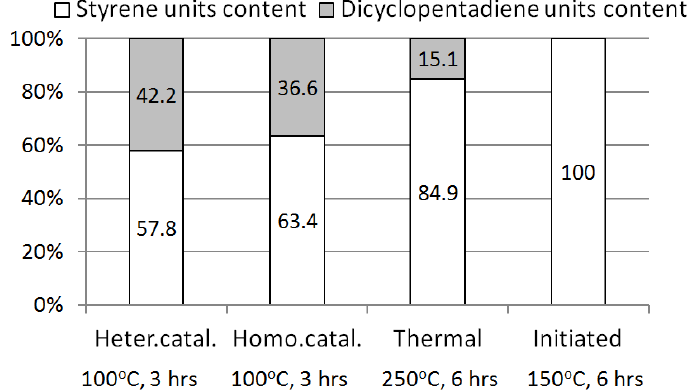
Figure 12. Composition of the cooligomers synthesized by different